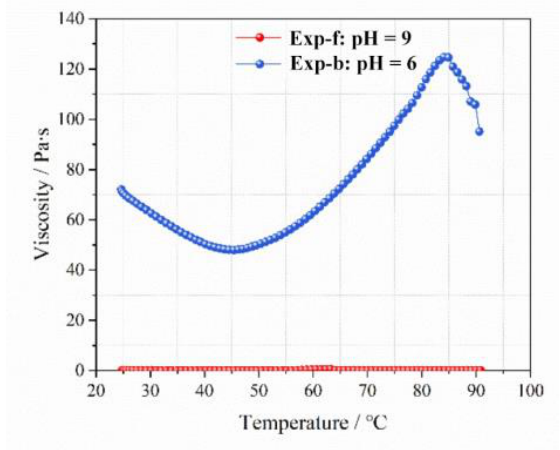
Figure 7. Viscosity with increasing temperature at pH values of 6 and 9.